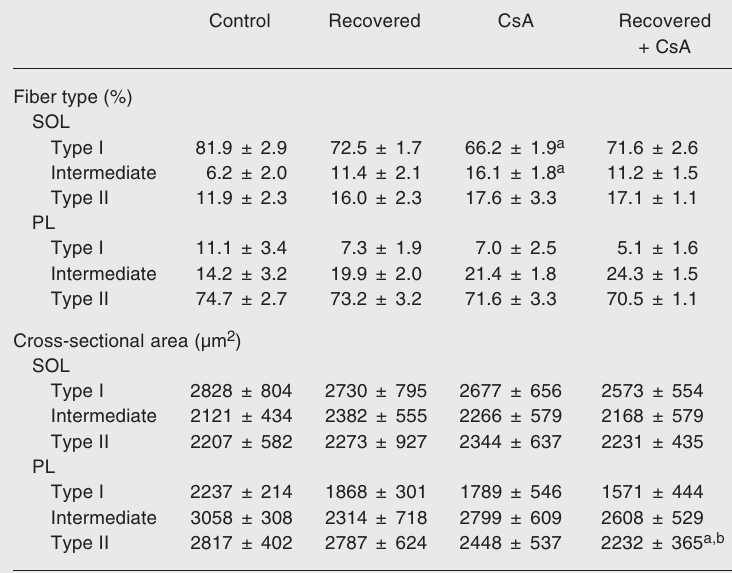
Table 4. Muscle fiber composition and cross-sectional area of the soleus (SOL) and plantaris (PL) muscles of recovered rats, rats receiving cyclosporin-A (CsA), and recovered rats receiving